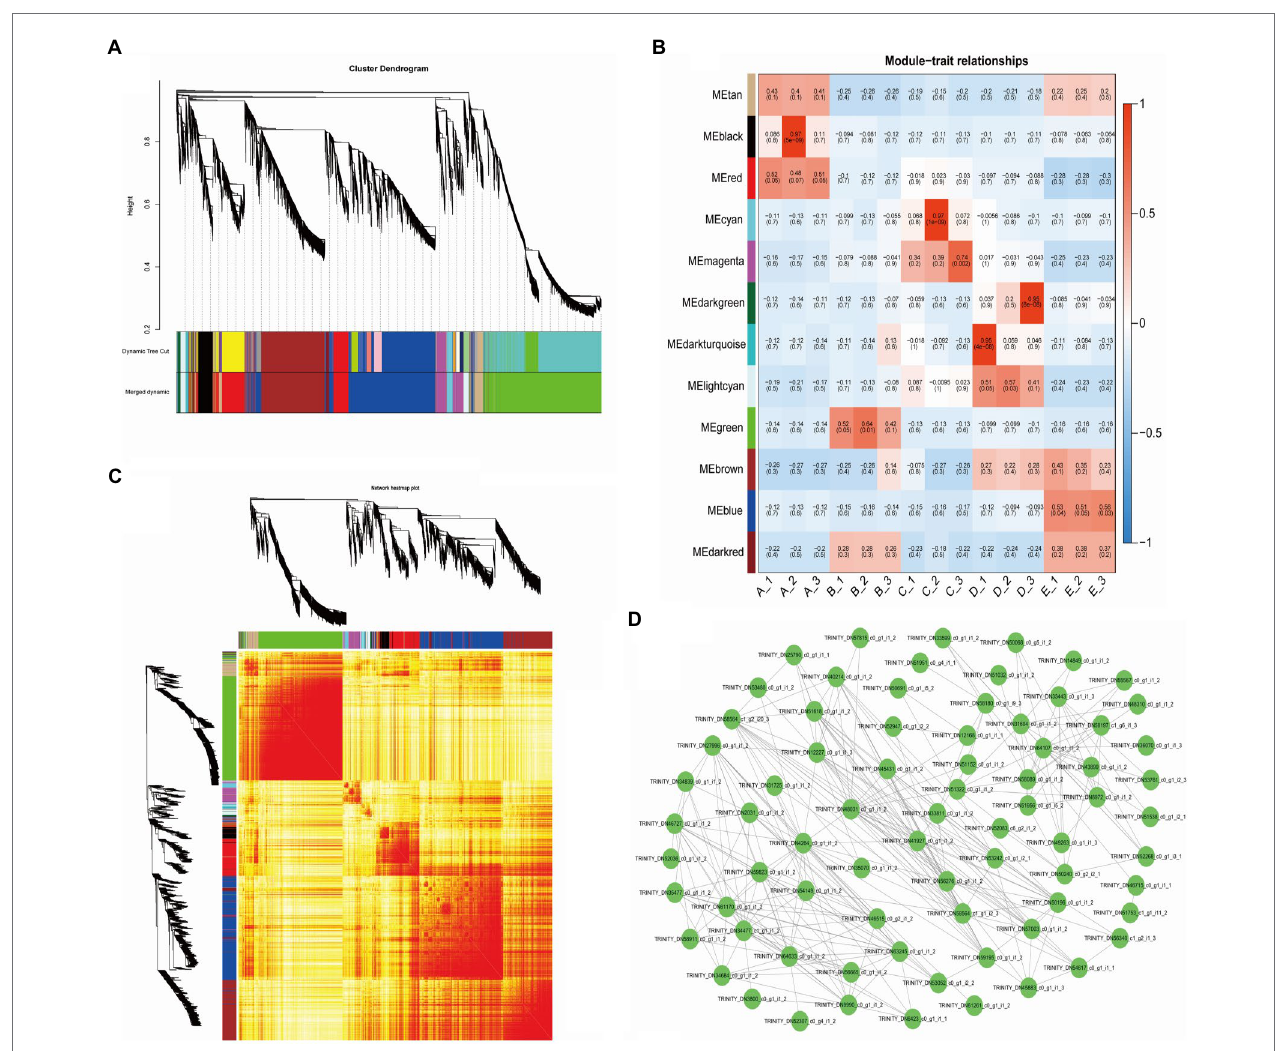
FIGURE 3 | Weighted gene coexpression network analysis of DEGs. (A) Cluster dendrogram of 12 different expression modules. (B) Module-trait relationships. The x-axis shows the sample, and the y-axis shows the modules and significance, respectively. (C) Network heatmap plot. (D) Network of MEmagenta module